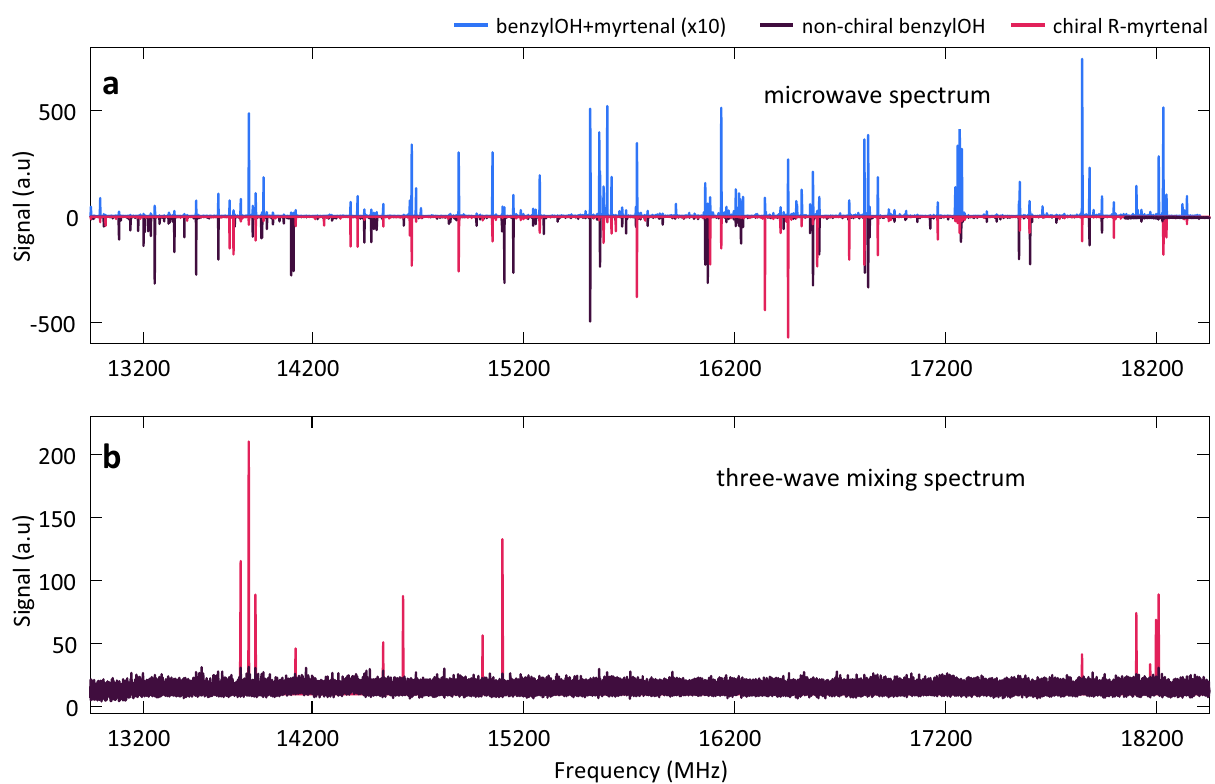
Fig. 2 Comparison between microwave spectra and three-wave mixing spectra. a Top in light blue, microwave spectrum of the mixture of (R)-myrtenal (chiral) and benzyl alcohol (non-chiral). Amplitudes are multiplied by a factor of 10 for better visibility. Inverted, in dark purple and pink, the microwave spectra of the individual species, benzyl alcohol and myrtenal respectively. b Three-wave mixing spectrum of the mixture of (R)-myrtenal and benzyl alcohol. Each transition belongs to a chiral species in enantiomeric excess. In pink, only transitions from enantiopure (R)-myrtenal survive